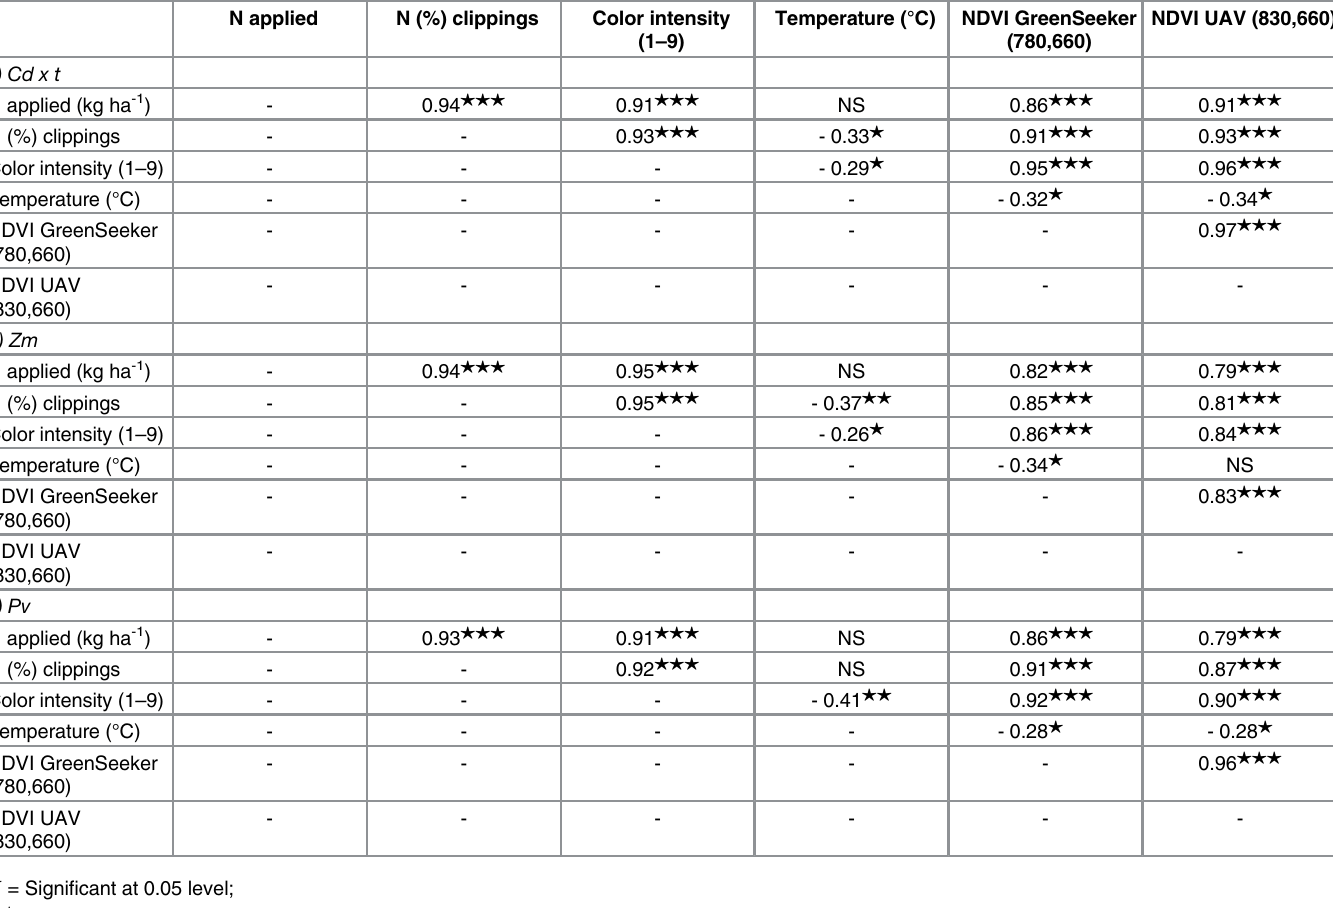
Table 1. Pearson product-moment correlation coefficients (r) among the nitrogen applied, clippings nitrogen content, color intensity, temperature, NDVI measured with a ground-based instrument (Trimble ’ s GreenSeeker sensor) and NDVI measured with an unmanned aerial vehicle (UAV) on a) Cynodon dactylon x transvaalensis ; b) Paspalum vaginatum ; c) Zoysia matrella . In each species correlation coefficients are calculated across all